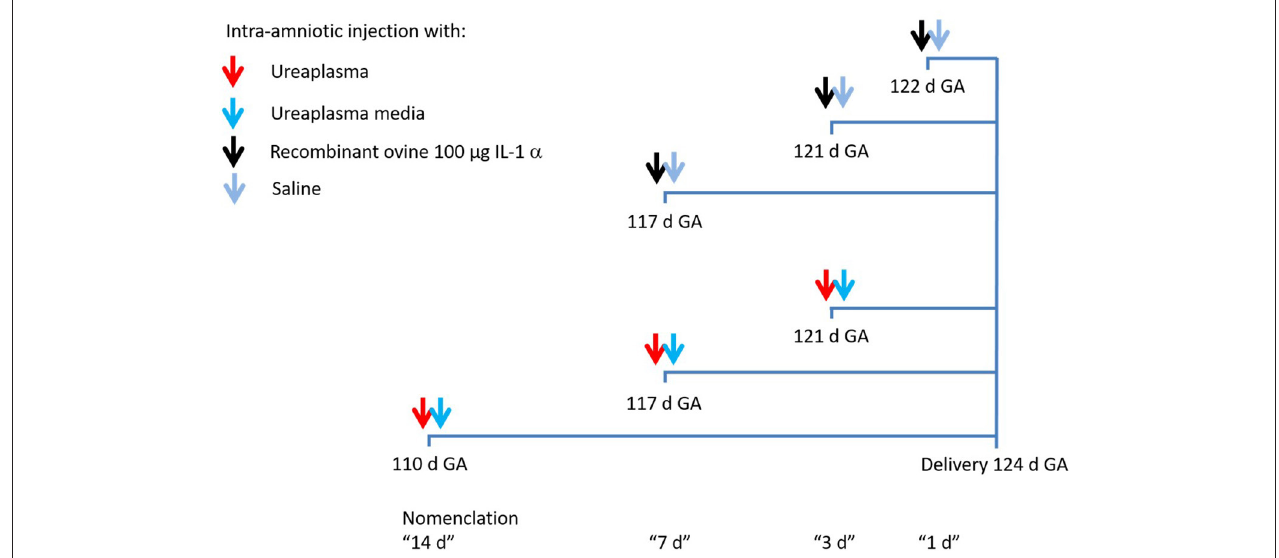
FIGURE 1 | Experimental design. Antenatal inflammation was induced by a single injection of IL-1 α under ultrasound guidance at 117, 121 or 122 d gestational age (GA) or Ureaplasma parvum at 110, 117 or 121 d GA. Animals were delivered at 124 d GA and animals of the control group underwent the same procedure with an injection of saline or Ureaplasma